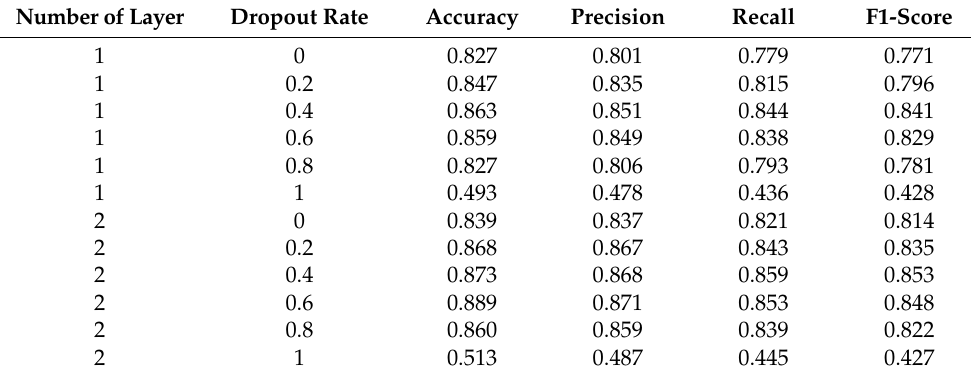
Table 3. Experiment results of ERNIE-BiLSTM approach.